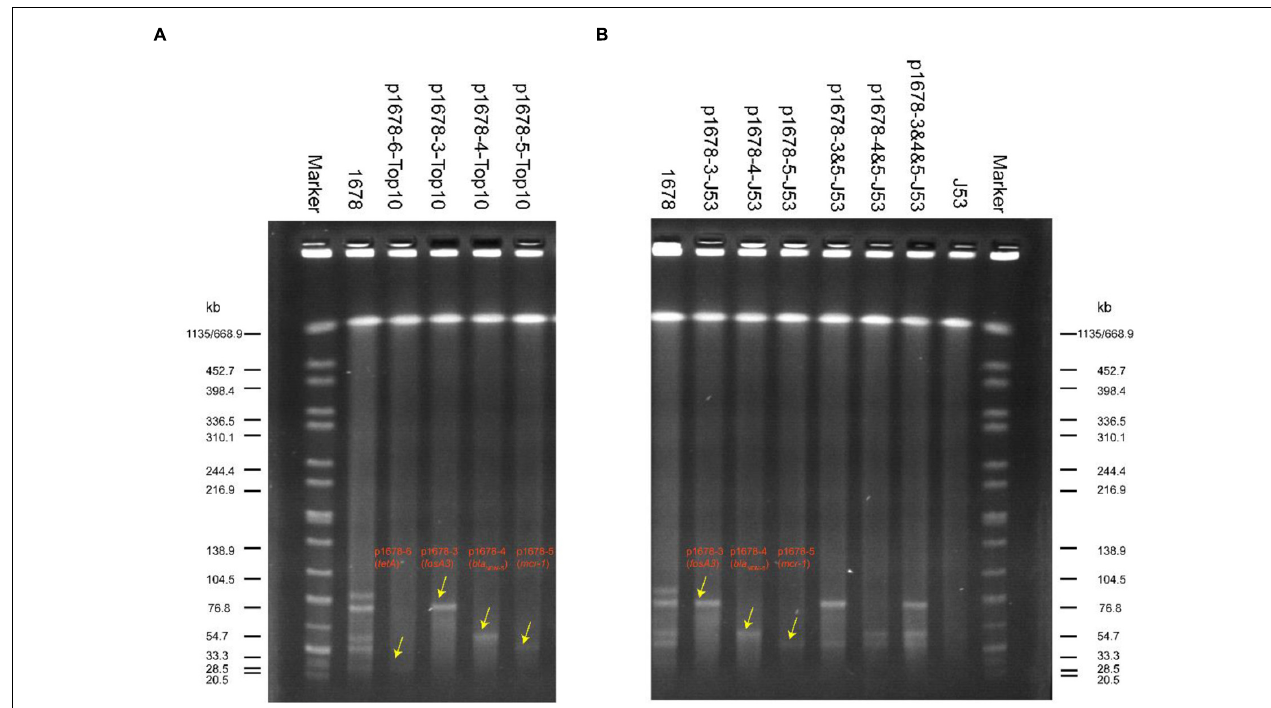
FIGURE 1 | SI-PFGE profiles of original K. pneumoniae 1678 and its transformants (A) and transconjugants (B) . Lane marker was XbaI -digested DNA of Salmonella Braenderup H9812; Lane 1678 and Lane J53 were used as positive reference and negative control, respectively; transformants: p1678-6-Top10 ( tetA ),